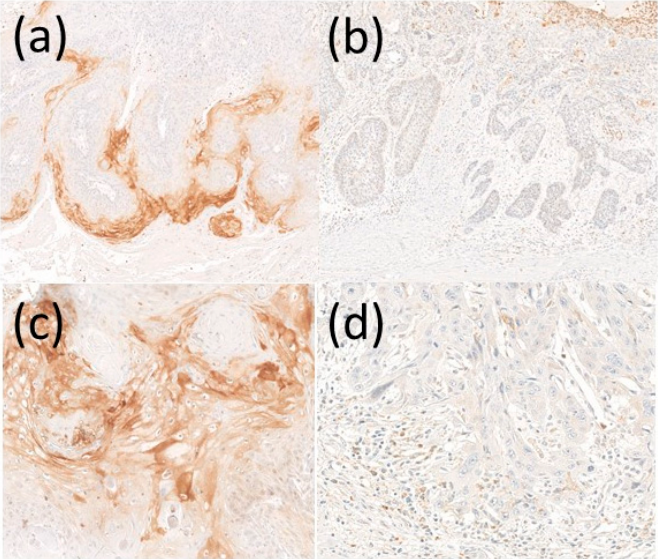
Figure 1. Representative CADM1 expression on cSCC. CADM1 expression was analyzed by immunohistochemical staining in patients with ( a ) high CADM1 expression and ( b ) low CADM1 expression. ( c ) High magnification view of high CADM1 and ( d ) low CADM1 expression. Table 2. Relationship between the CADM1 expression and clinicopathological variables of CSCC.